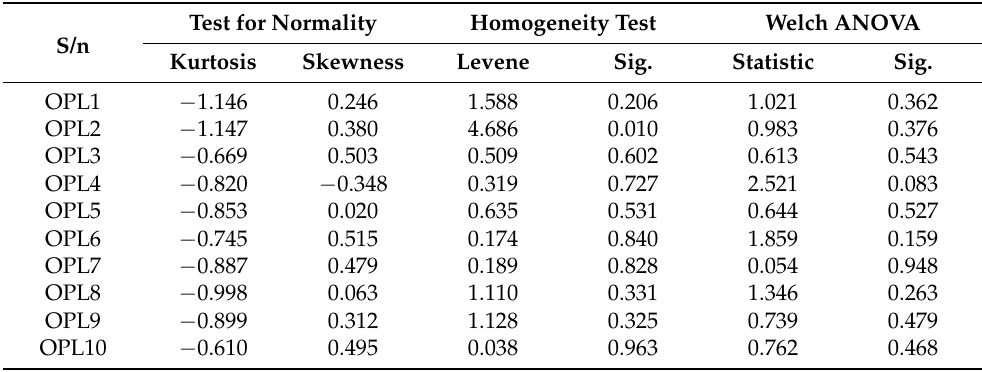
Table 3. One-way analysis of variances (ANOVA) for H&S considerations at the planning stage. Test for S/n